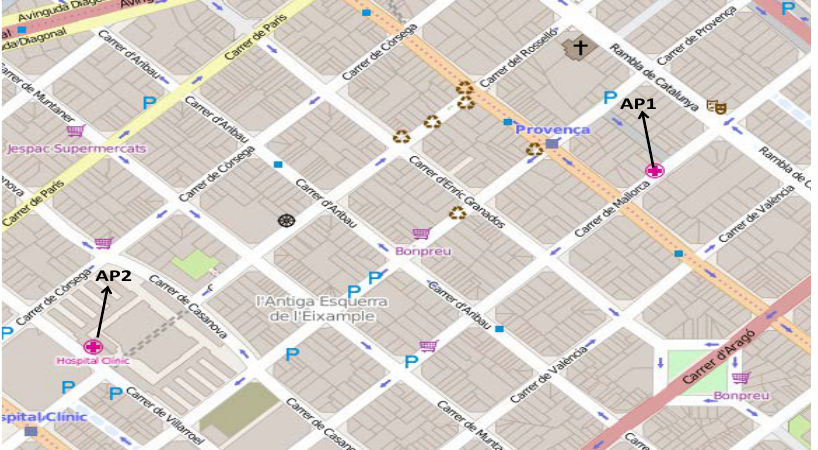
Figure 18. Simulation scenario of Barcelona, Spain (N = 2 users). It includes two emergency units: AP1 (Ana Torres surgery clinic) and AP2 (Hospital Clinic of